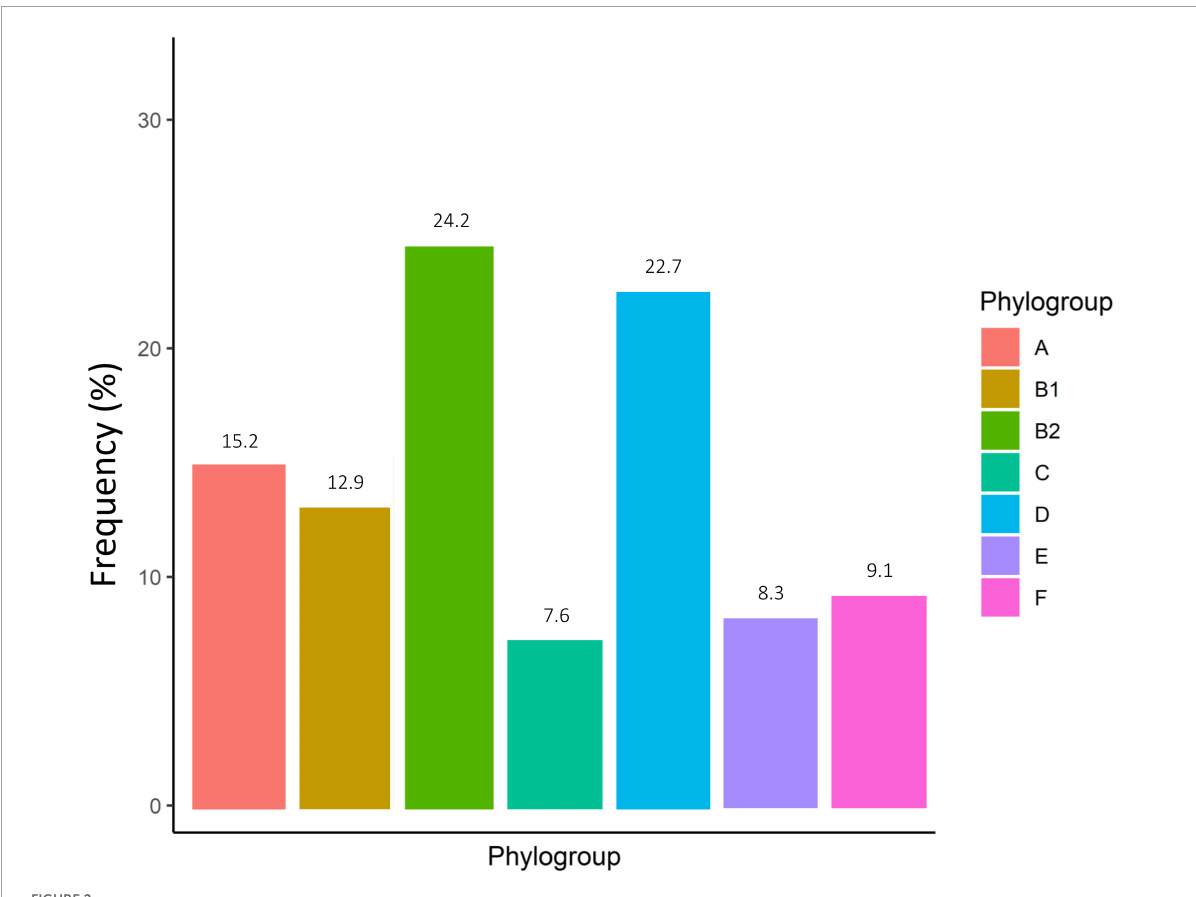
FIGURE2 Frequency of phylogenetic groups of E. coli isolates in Iranian IBD patients.